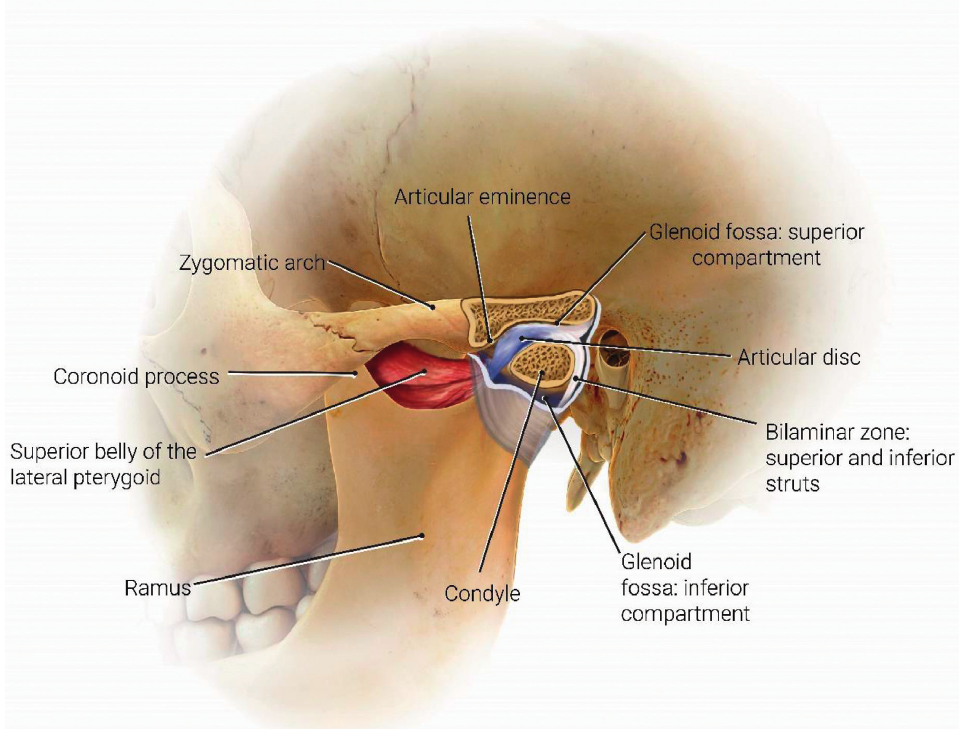
Figure 2: Normal anatomy illustrating the condyle of the mandible, superior and inferior belly of the lateral pterygoid muscle, articular disc, articular eminence of the temporal bone, and articular fossa (glenoid fossa) of the temporal